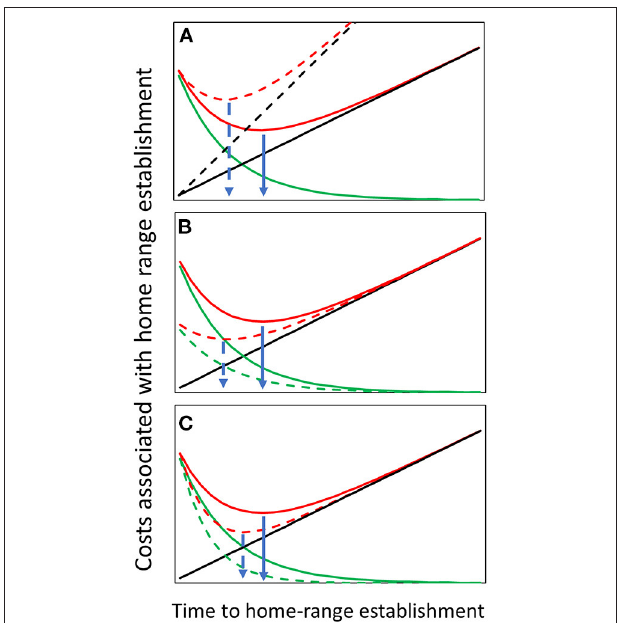
FIGURE 1 | The two costs involved in establishing a home range: search costs in black and missed opportunity costs (MOC) in green. Search costs increase with time. MOC increase with the variability of habitat conditions over space and decrease with time as the animal’s assessment of space improves. The sum of both costs is in red, and the optimal stopping time is when this sum is minimized (indicated by the blue arrows). Each of the three sub-figures (A–C) compares the stopping time between two formulations of one of the cost functions. (A) If search costs increase (black dashed line) optimal stopping time is reduced. (B) If habitat variability over space is reduced (green dashed line) stopping time is reduced. (C) If competition is high (i.e., the better areas become unavailable) the variance in potential habitats declines reducing optimal stopping